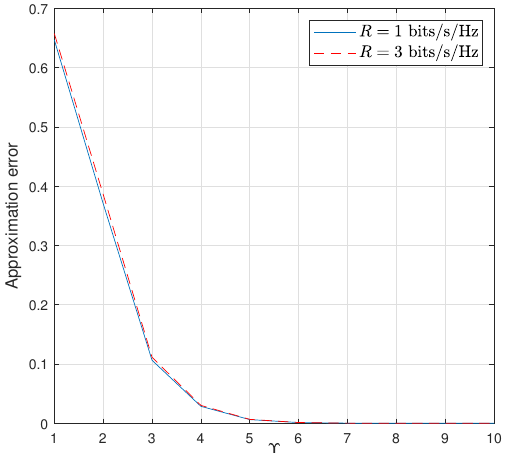
Figure 3. Relative approximation error versus parameter Υ of the WP DH AF relaying system for P T = 40 dB, and P th = 35 dB.